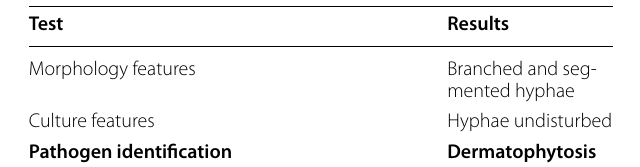
Table 6 Mycology analysis